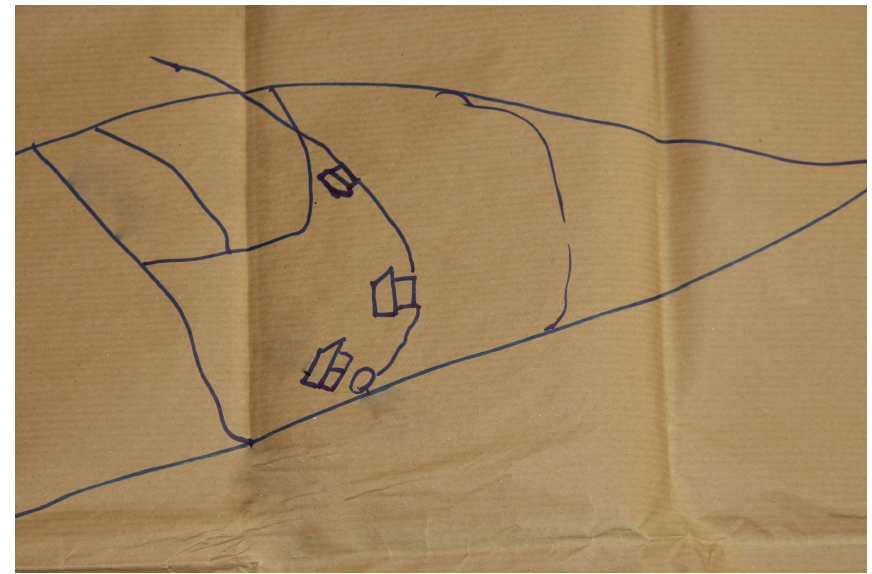
Figure 2. Example of sketch map with aerial view and high level of abstraction.